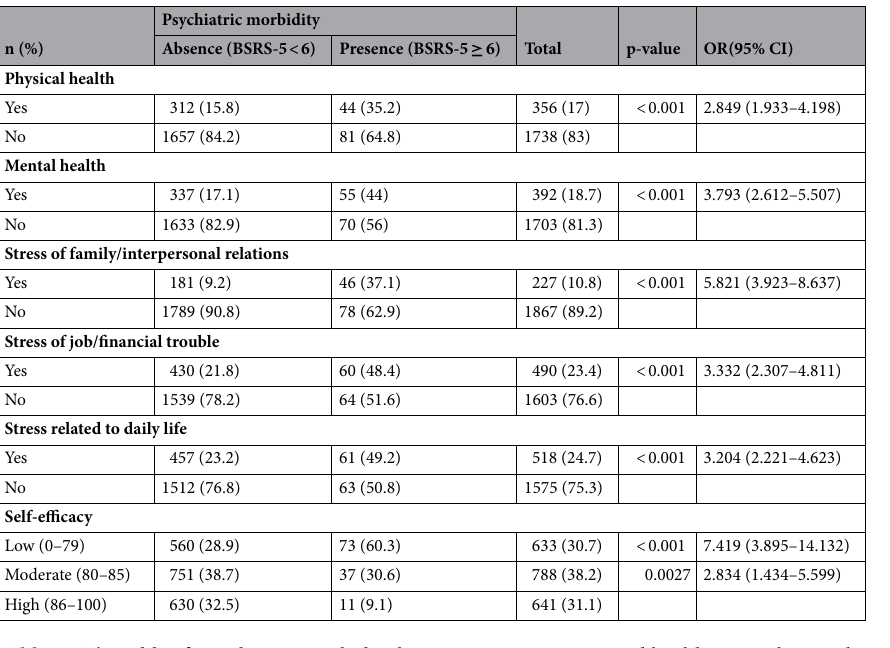
Table 3. The odds of psychiatric morbidity by COVID-19 stressors and health or psychosocial variables. All the above-mentioned data were weighted; missing data were excluded for analysis. BSRS-5: The Five-item Brief Symptom Rating Scale; OR: odds ratio; CI: confidence interval.